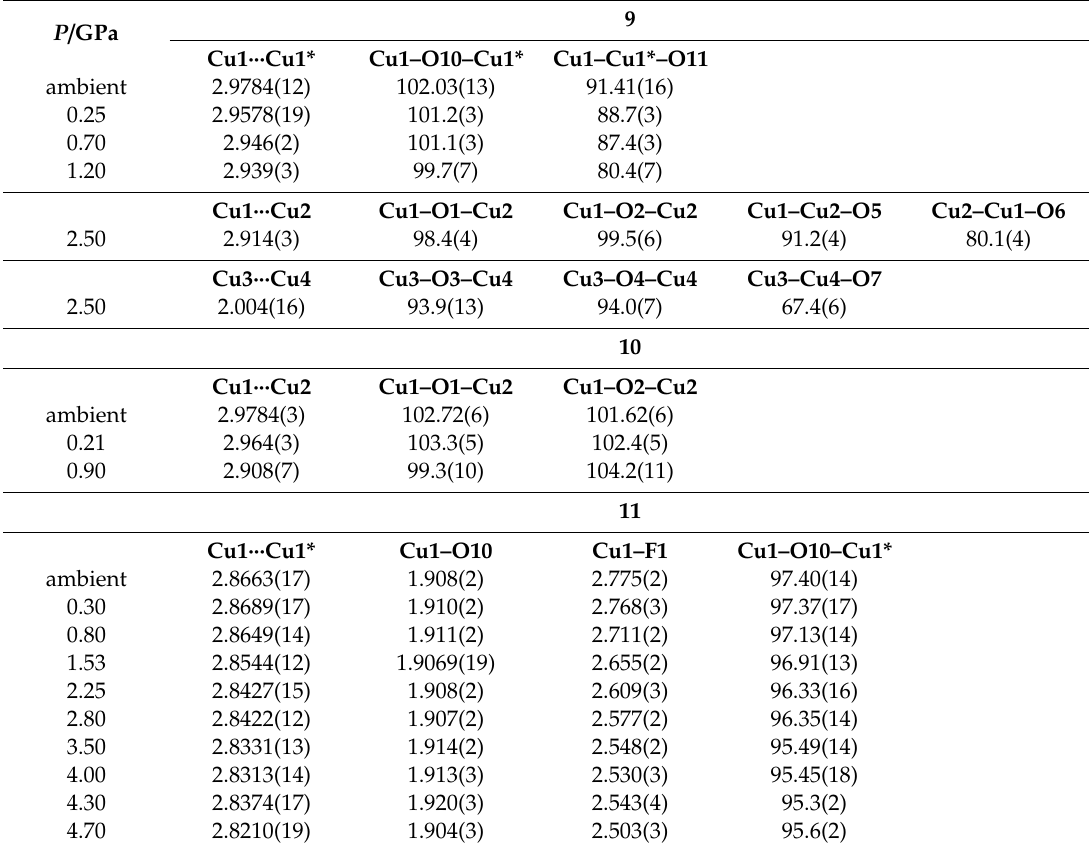
Table 6. Selected distances (Å) and angles ( ◦ ) in compounds 9–11 as a function of pressure (GPa). P /